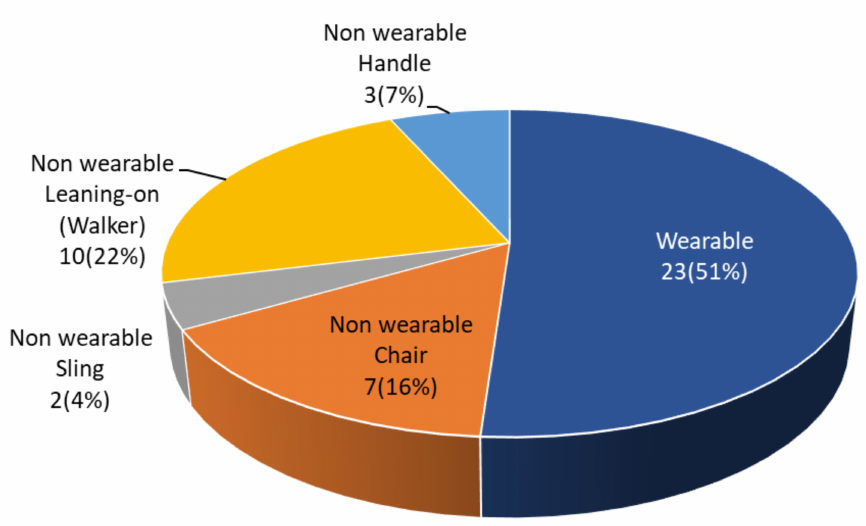
Figure 3. Summary of assistance